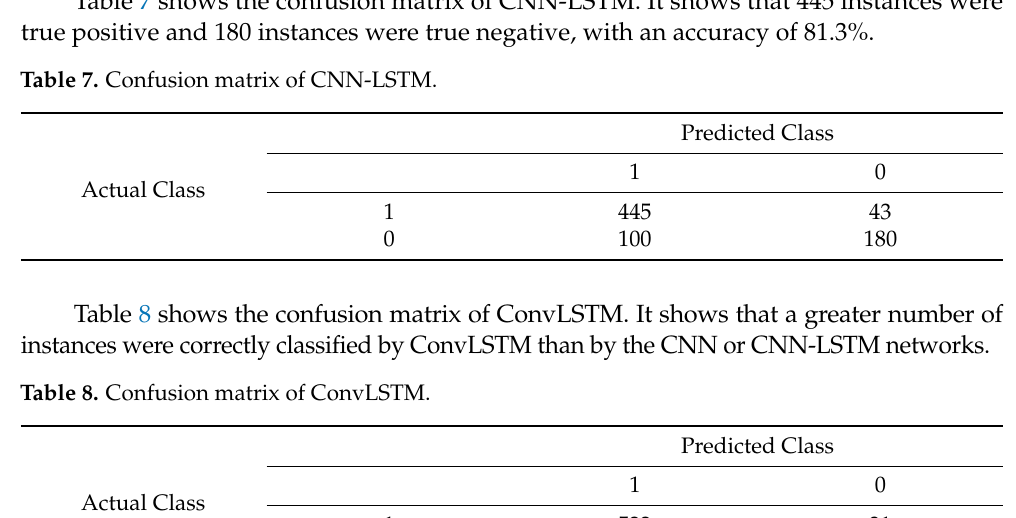
Figure 3. AUC of SMOTE-based deep LSTM.